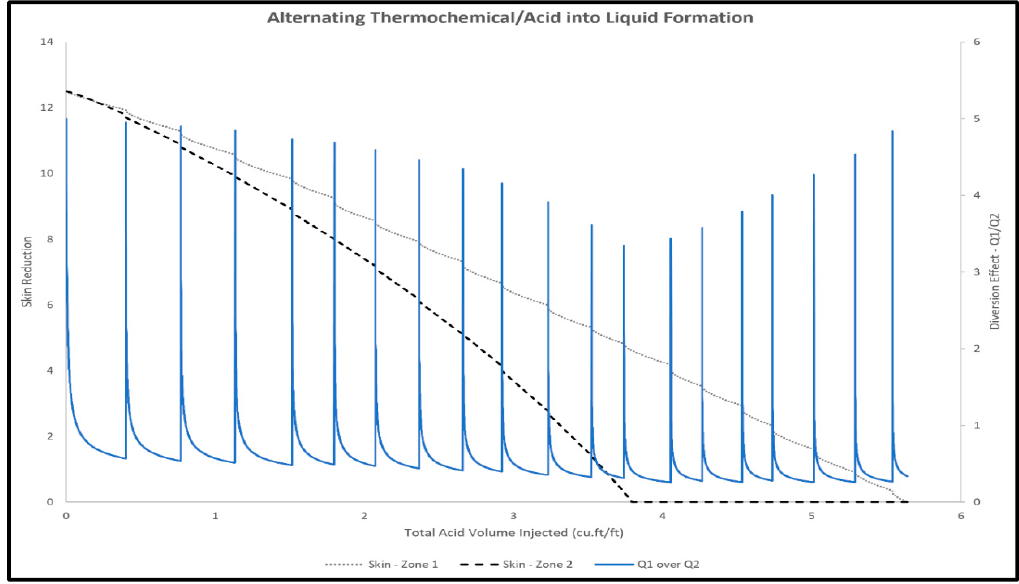
Figure 14. Skin reduction during alternating thermochemical and acid injection into high- (zone 1) and low-permeability layers (zone 2).